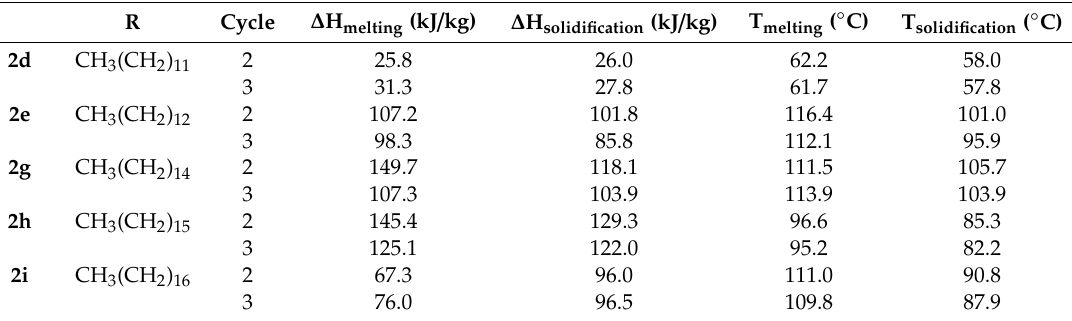
Table 2. Summary of the di ff erential scanning calorimeter (DSC)results of the solid monoamides showing phase change transition under the experimental conditions assayed.